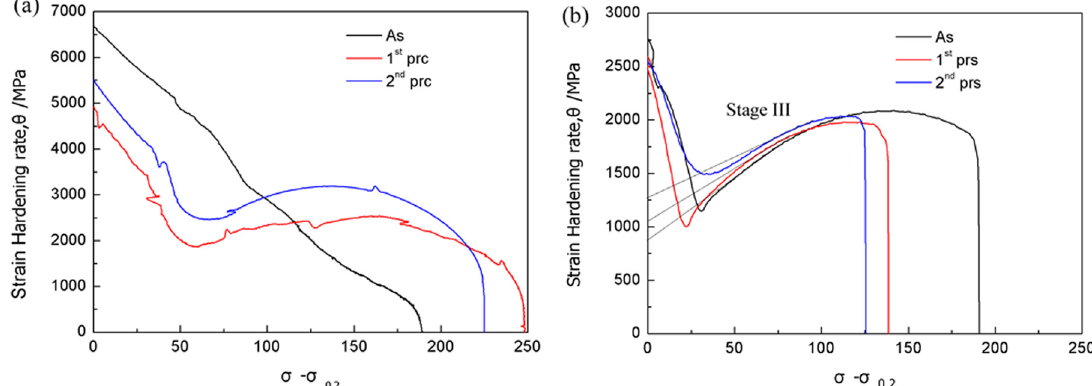
Figure 7. The strain hardening rate of various pre-strained Mg specimens: (a) tension, (b)